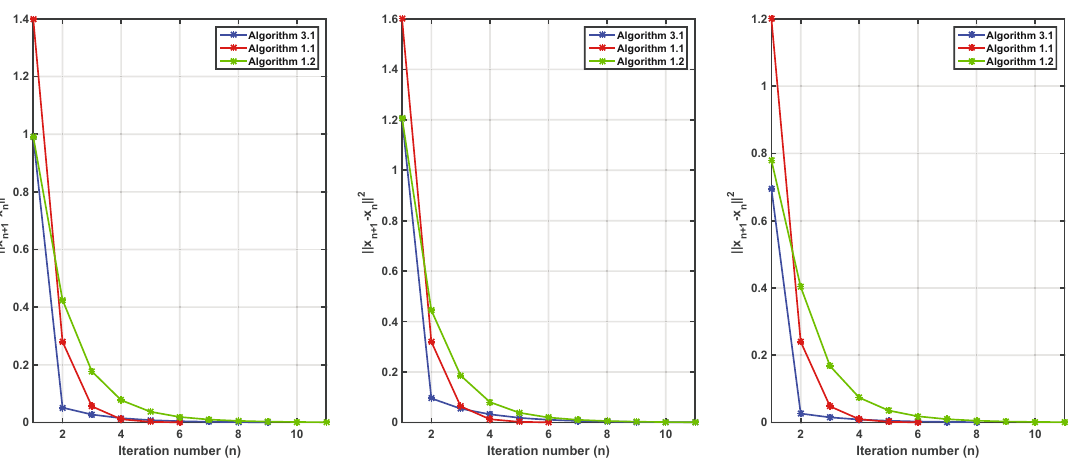
Algorithm 3.1 Algorithm 1.1 Algorithm 1.2